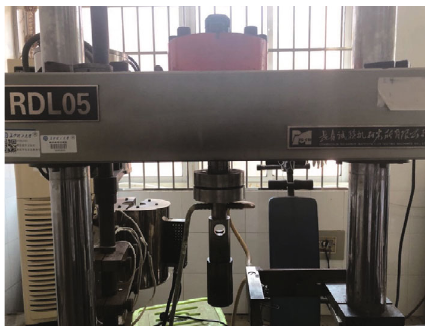
Figure 3: RDL05 testing machine of the tensile experiment. The maximum load of the machine is 50 kN.